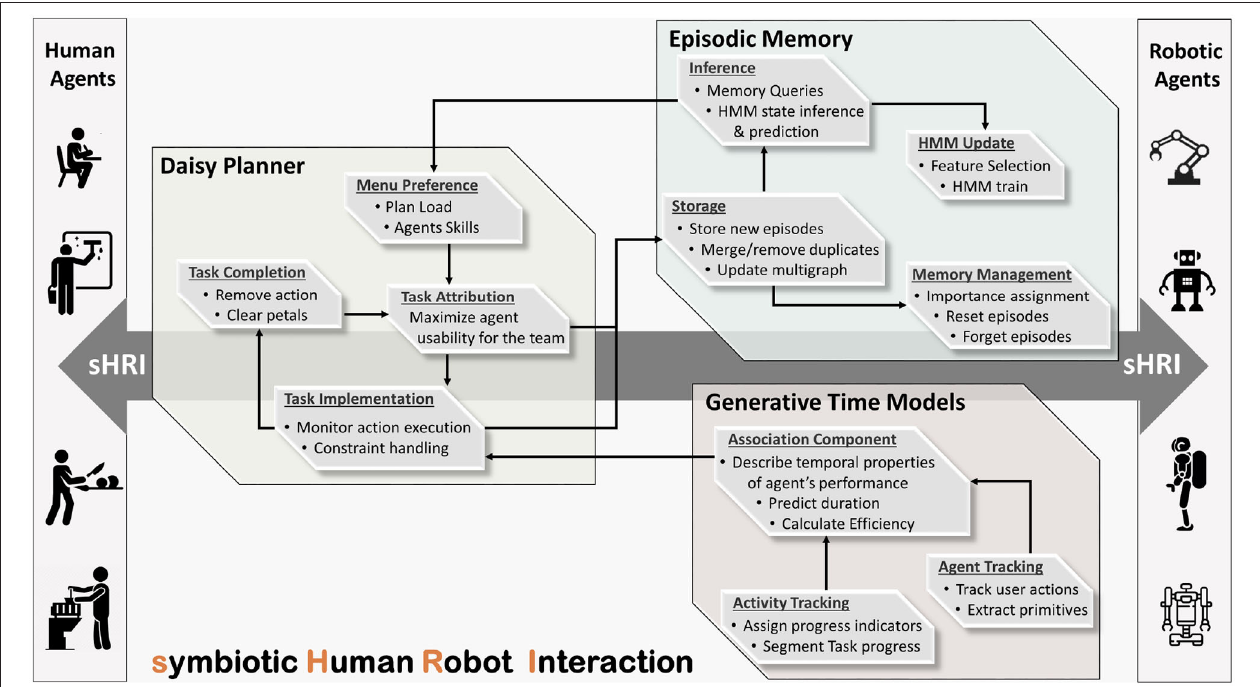
FIGURE 2 | Abstract representation of the proposed sHRI